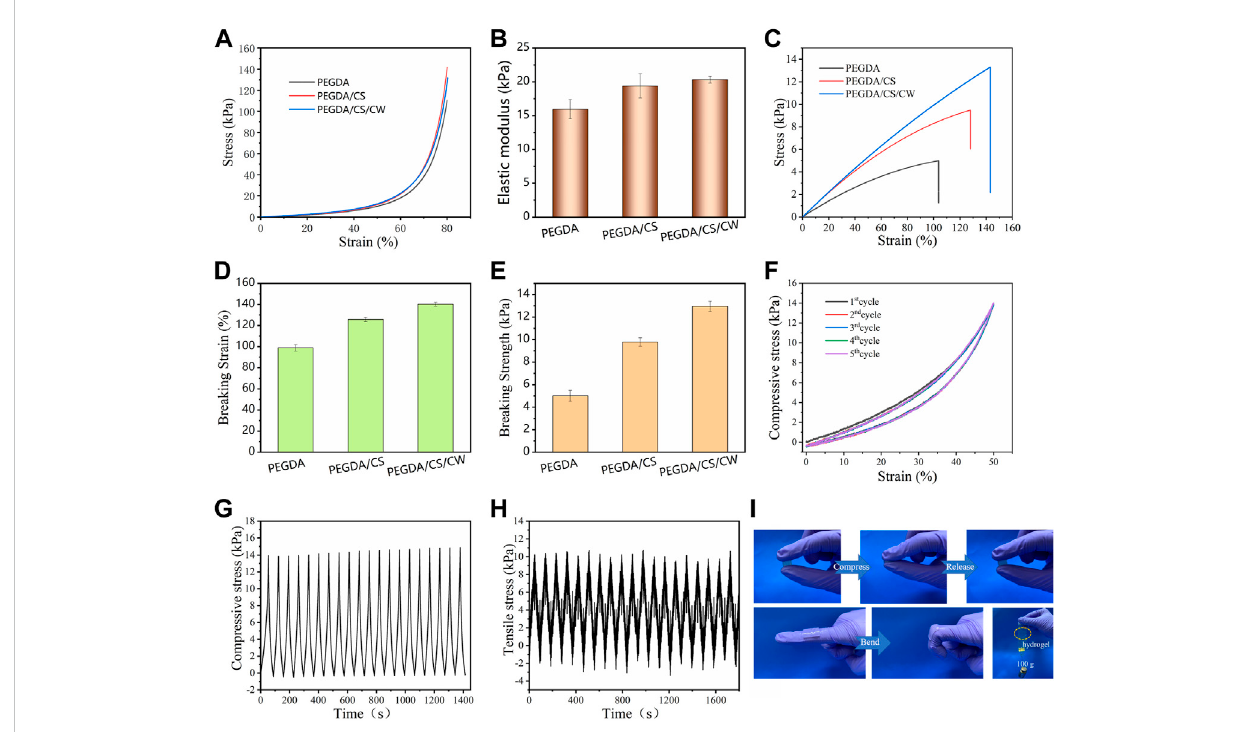
FIGURE 5 Mechanical properties of the hydrogel. (A) Compressive stress-strain curves. (B) Compressive elastic modulus. (C) Tensile stress-strain curves. (D) Breaking strain, and (E) breaking strength of PEGDA, PEGDA/CS and PEGDA/CS/CW hydrogel. (F) Cyclic compressive stress-strain curves. (G) Compressive cyclic stress-time and (H) cyclic tensile stress-time curves of the PEGDA/CS/CW hydrogel. (I) PEGDA/CS/CW hydrogel mechanical properties and adhesion performance display pictures.